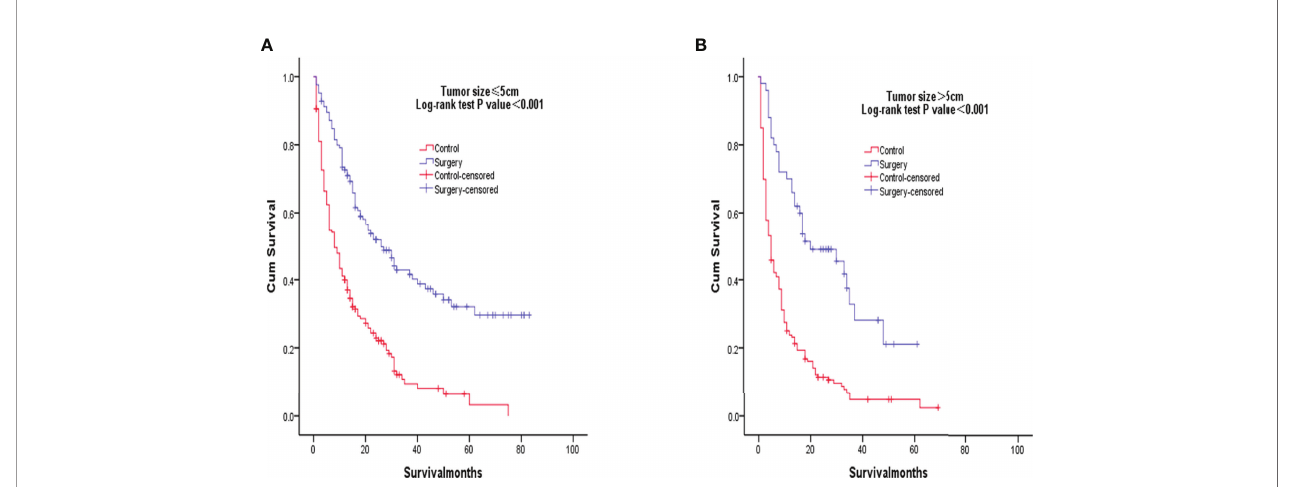
FIGURE 5 | Kaplan-Meier overall survival curves of surgery-treated patients vs control after propensity score matching strati fi ed by Tumor size, ≤ 5cm (A) , >5cm) (B) .